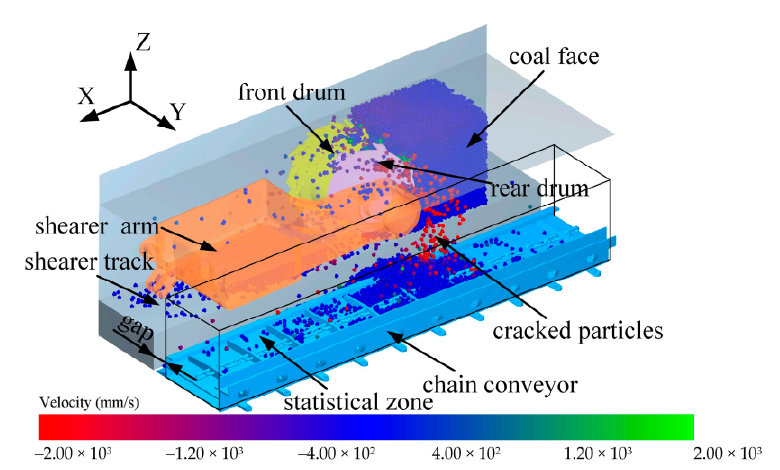
Figure 9. The simplified diagram of the model in